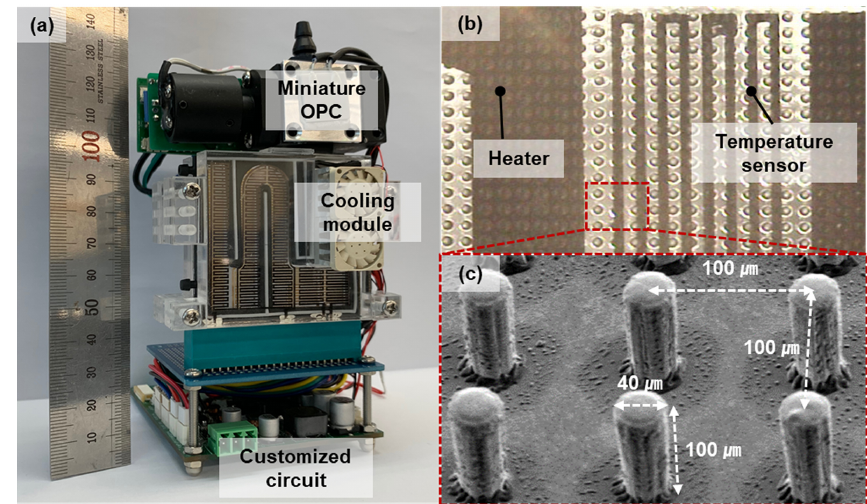
Figure 2. (a) Optical image of the MEMS-based CPC. (b) Magnified image of the heaters, resistive temperature sensors, and wick on the glass slide. (c) Image from a scanning electron microscope (SEM) of the micropillar-type wick.